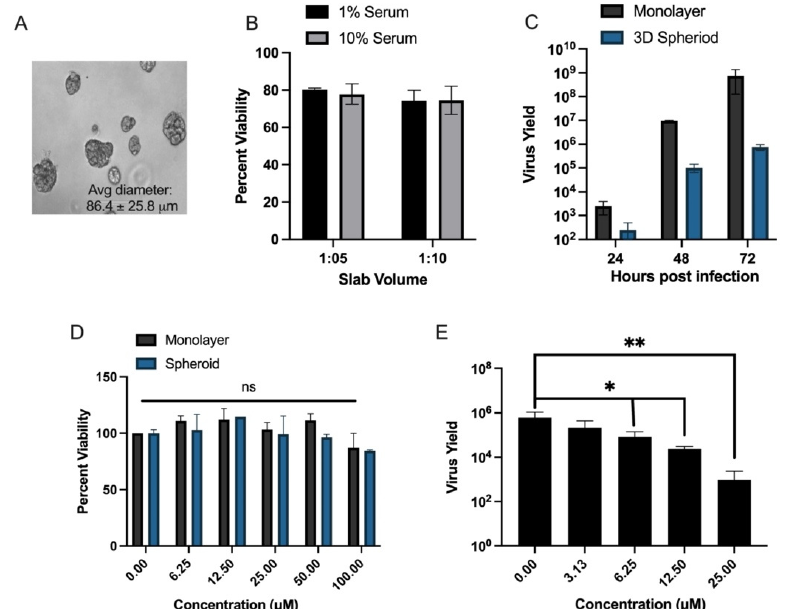
Figure 4. Evaluation of a 3D human hepatoma spheroid model for YFV infection and antiviral com- pound activity. Huh-7 cells were plated in a 1:5 or 1:10 suspension of media: Matrigel ® in 1% or 10%